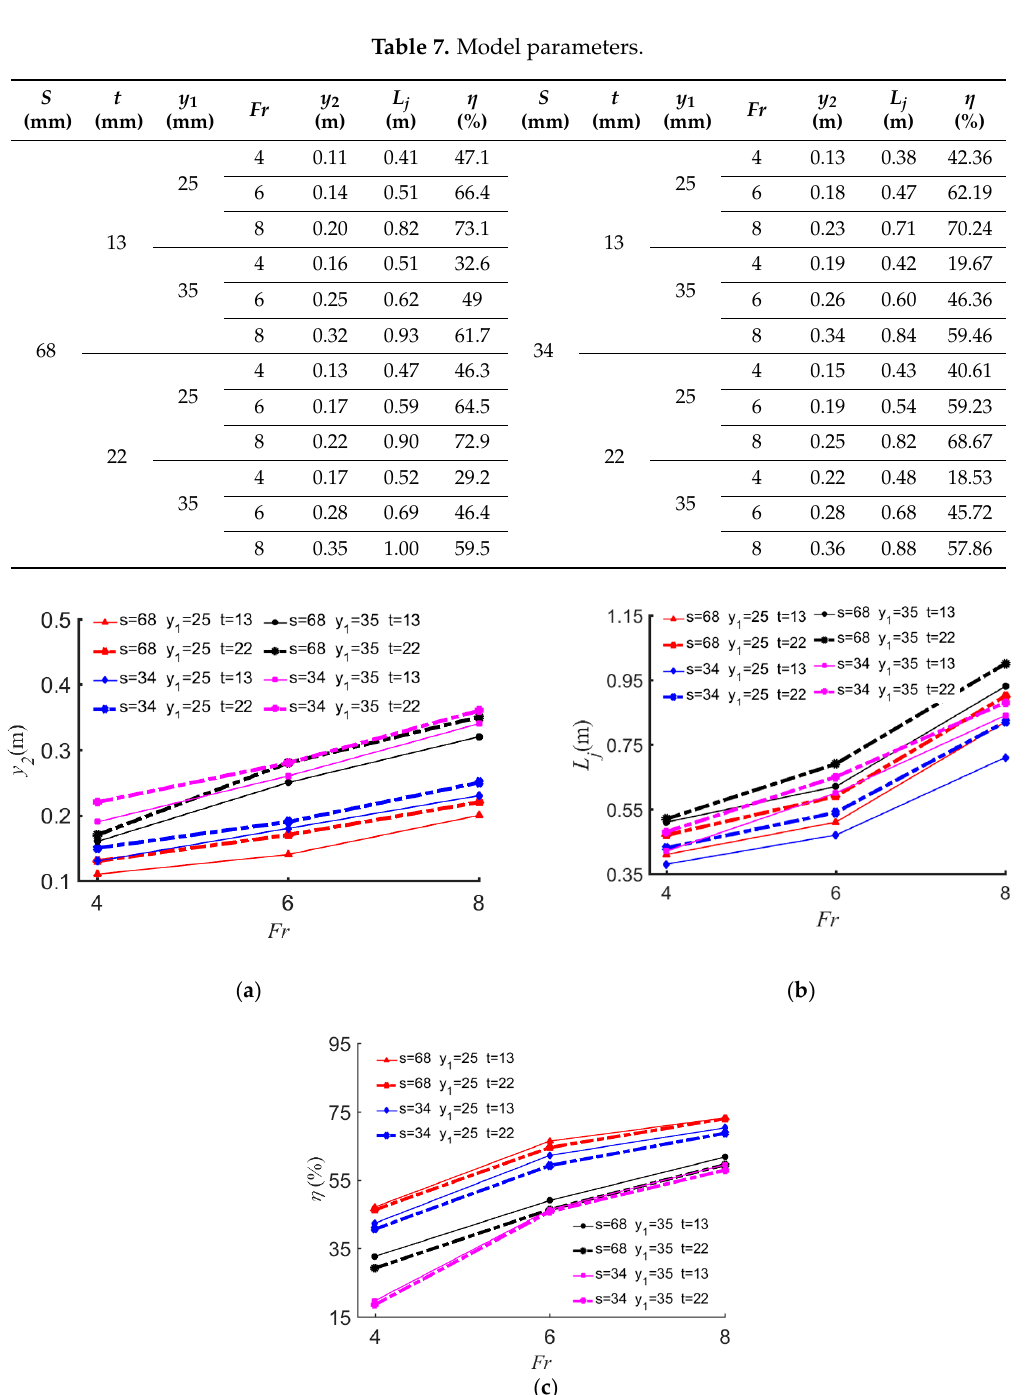
Figure 10. Water depth after hydraulic jump, jump length, and energy dissipation rate vary with corrugation height. ( a ) Water depth after hydraulic jump; ( b ) jump length; ( c ) energy dissipation